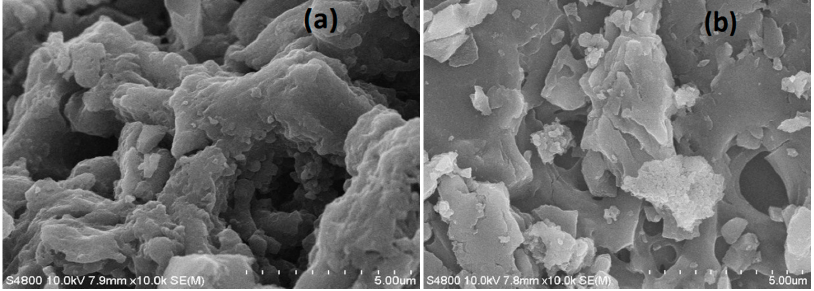
Figure 3. SEM image of raw XSBL ( a ) and XSBLAC ( b ).